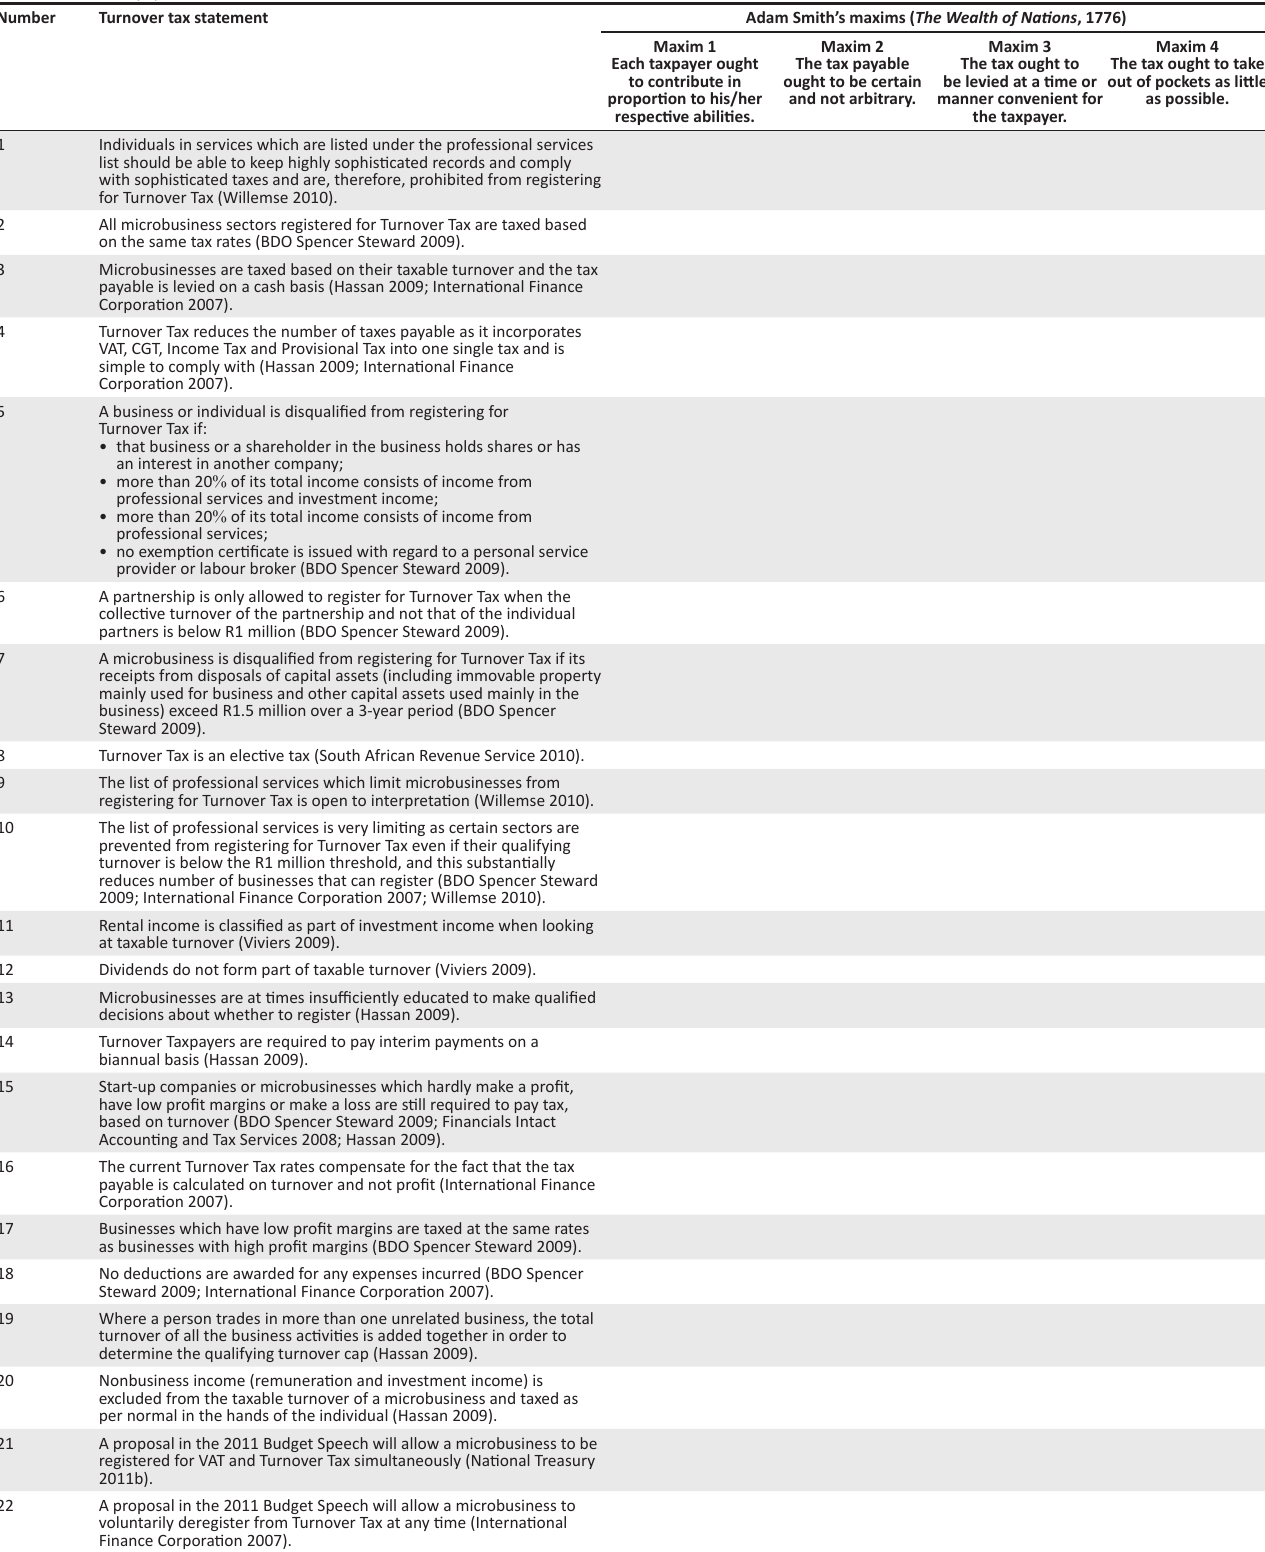
TABLE 1-A1: Survey